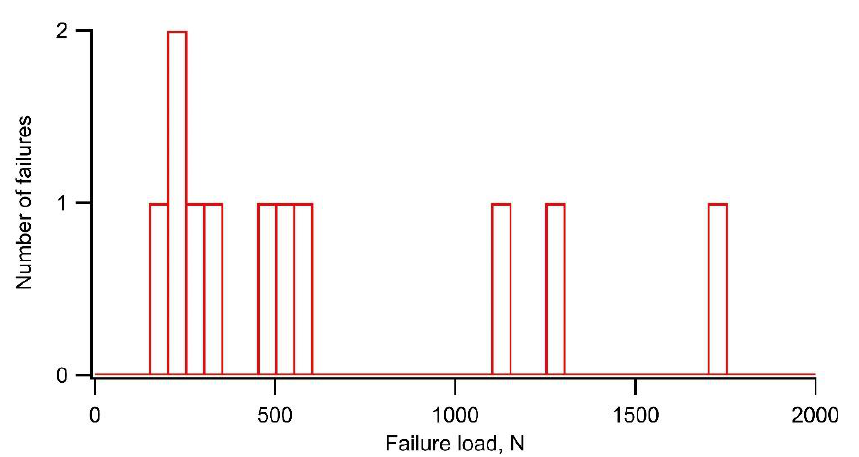
Figure 2. Distribution of the number of failures with respect to failure load on a-C:H films.